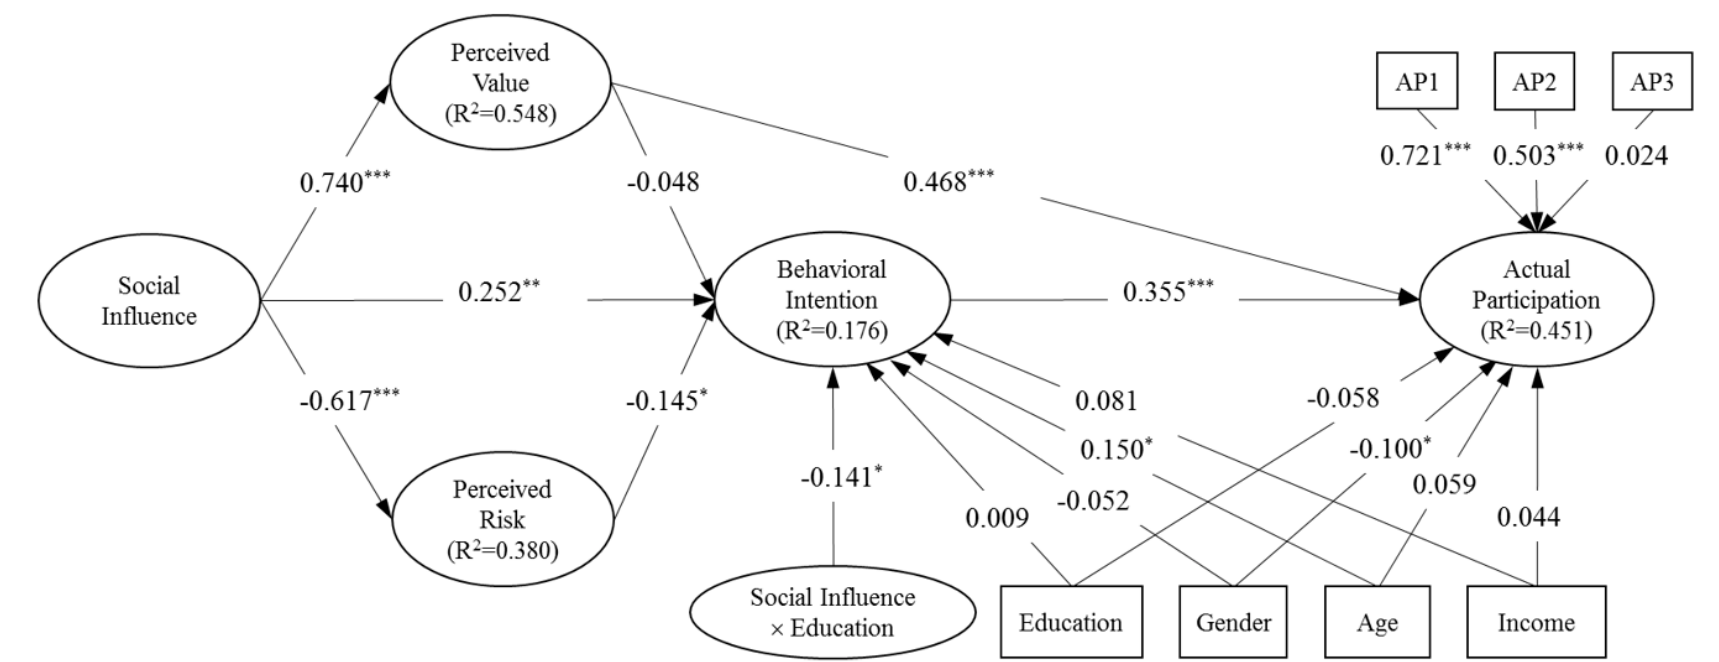
Figure 2. Standardized model estimates. *** p < 0.001. ** p < 0.01. * p < 0.05. two-tailed test.